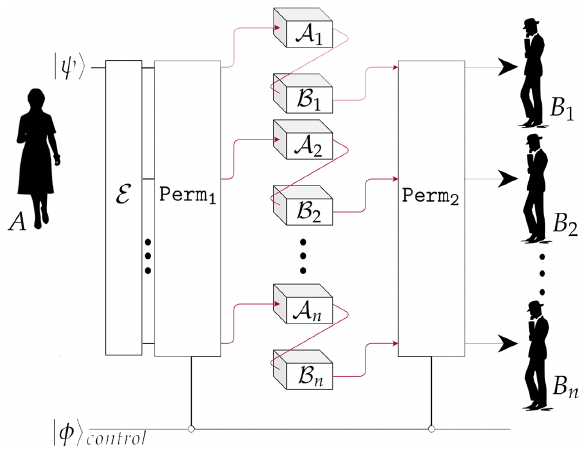
FIG. 4. Random-receiver quantum communication task with controlled permutations in space . A control qubit, initially in the state | φ (cid:3) , controls the choice of a permutation Perm 1 acting on the input systems. Then, the input systems are sent through the noisy channels, with system i passing through channels A i and B i in a definite order. Finally, a permutation to the outputs of the channels, with the choice of permutation depending on the state of the control